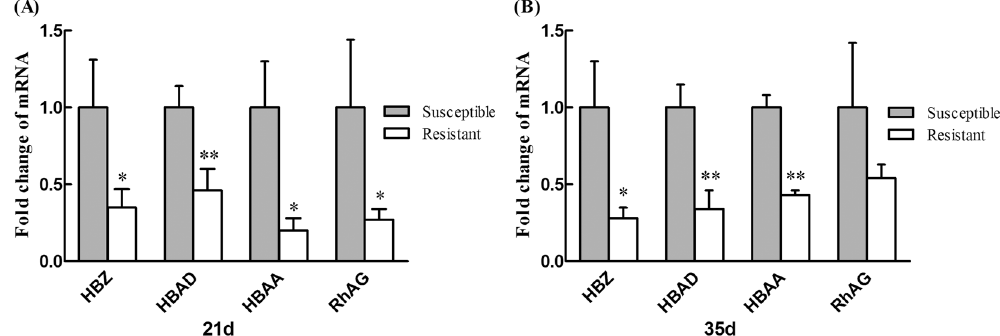
Figure 14. Validation of Hemoglobin zeta (HBZ), Hemoglobin alpha 2 (HBAD), Hemoglobin alpha 1 (HBAA) and Rh-associated glycoprotein (RhAG) mRNA expression in the resistant group and susceptible group on day (A) 21 and (B) 35. Data are mean ± standard deviation (SD). ** P < 0.01 and * P <